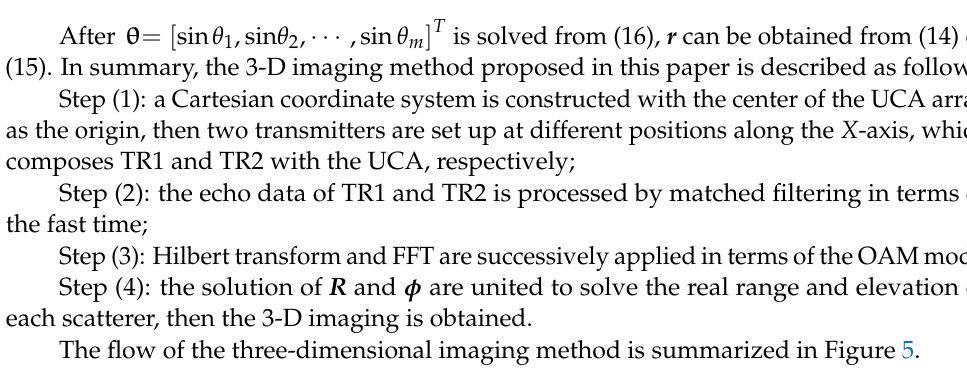
Step (4): the solution of R and φ are united to solve the real range and elevation of each scatterer, then the 3-D imaging is obtained. The flow of the three-dimensional imaging method is summarized in Figure